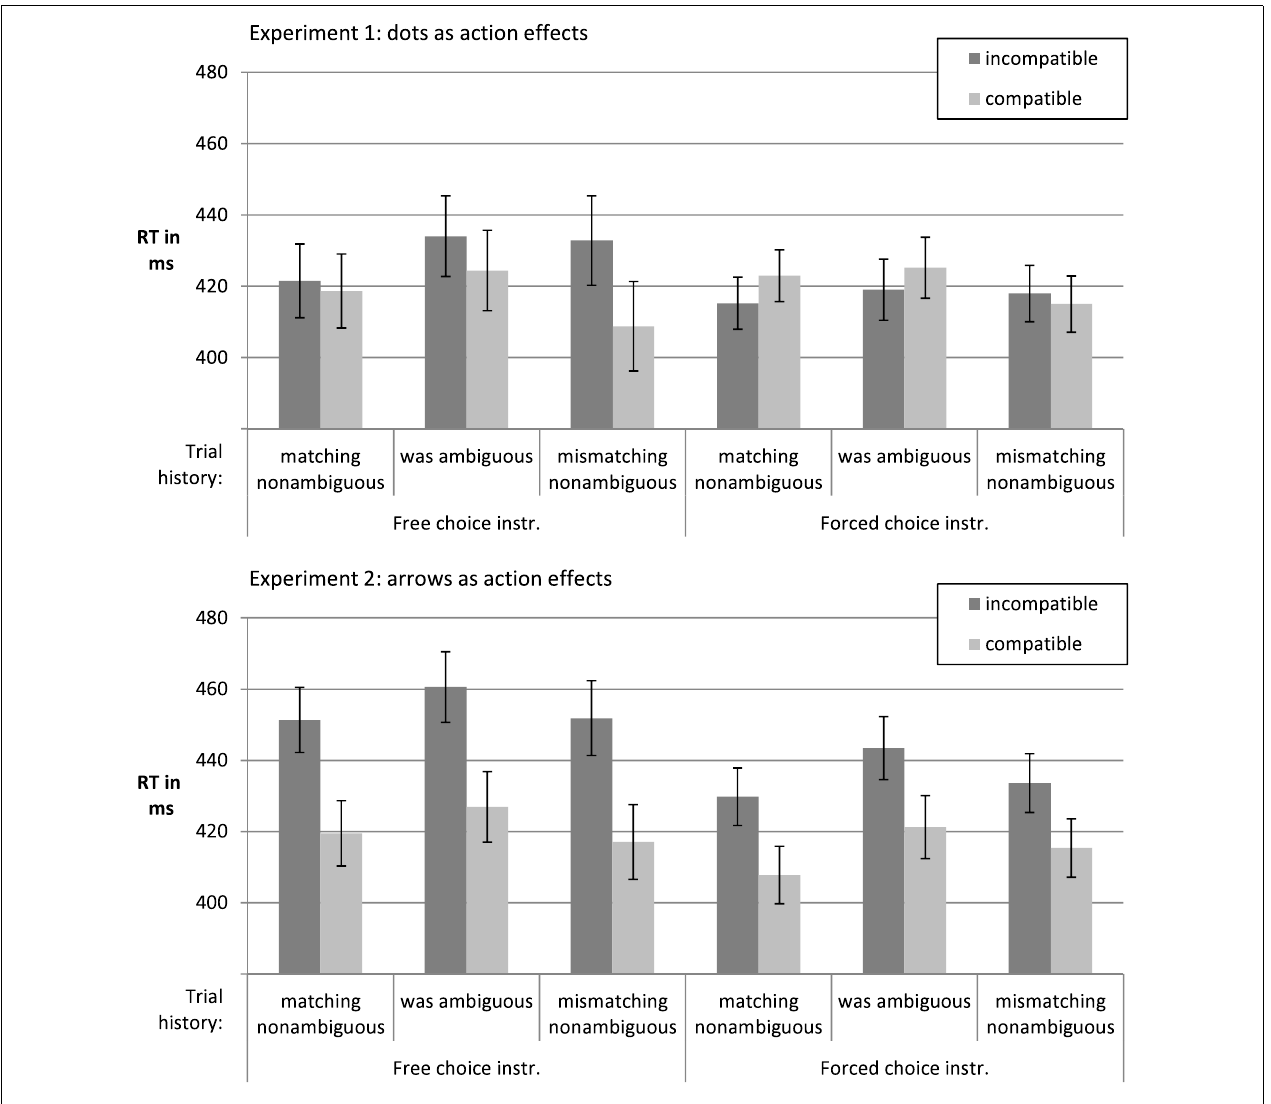
FIGURE 7 | RTs in trials with non-ambiguous stimuli depending on trial history and action effect compatibility.